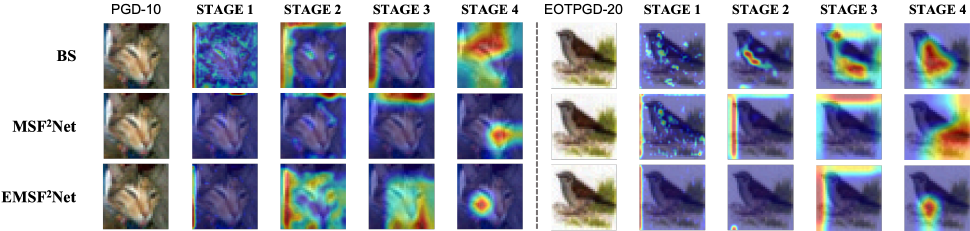
Figure 6. Grad-cam visualization results of the baseline, MSF 2 Net, and EMSF 2 Net under adversarial attacks with L ∞